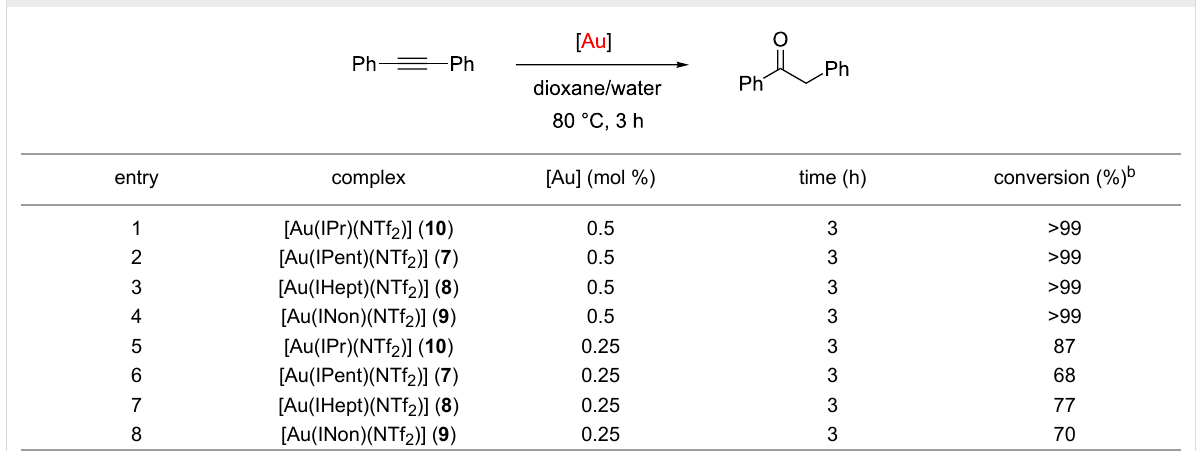
Table 1: Influence of the ITent ligands in gold-catalysed alkyne hydration.